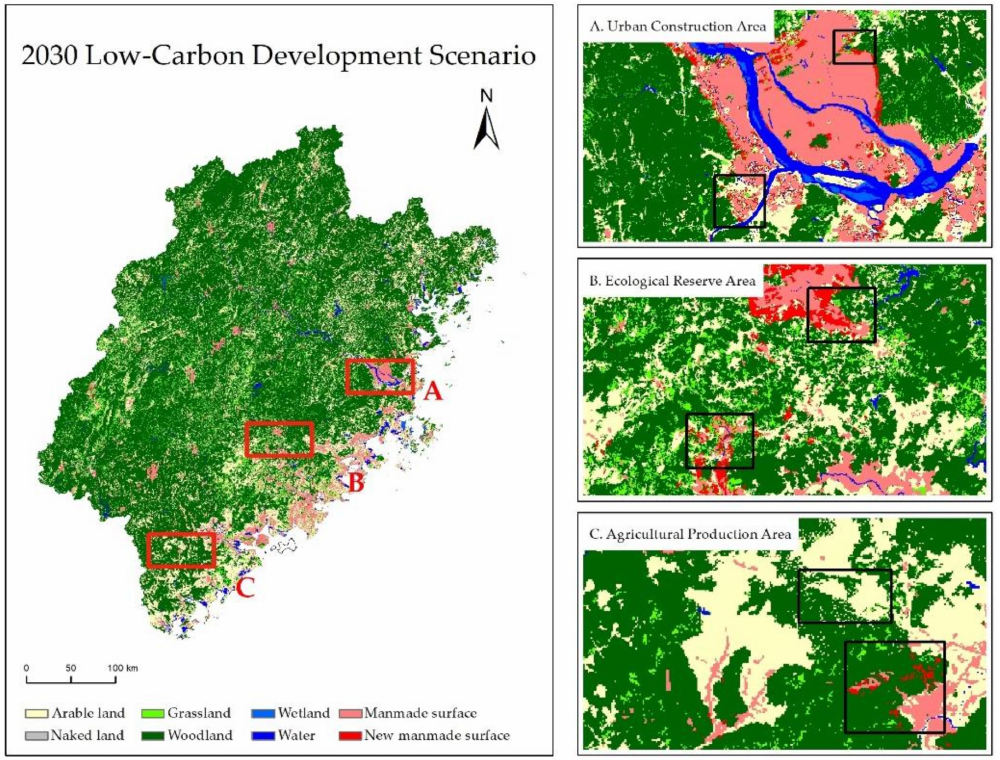
Figure 4. Land-use simulation map of Fujian Province under low-carbon development scenario in